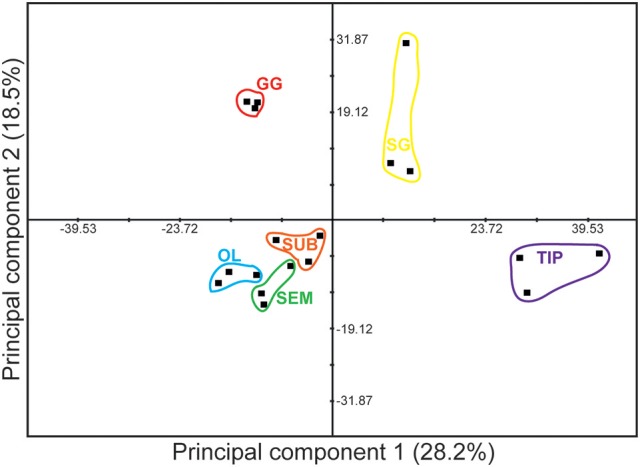
Principal Component Analysis of gene expression data based on transcript levels (in silico, see Figure 2) of 33 genes selected for this study (see Table 2 for full list). Data are plotted for tissue taken from three (N = 3) different animals. Dissimilarity between peripheral and central nervous system tissues emerged from the analysis with a clear distinction of the octopus gastric ganglion signature from other peripheral structures (i.e., stellate ganglion and arm). See text for details.